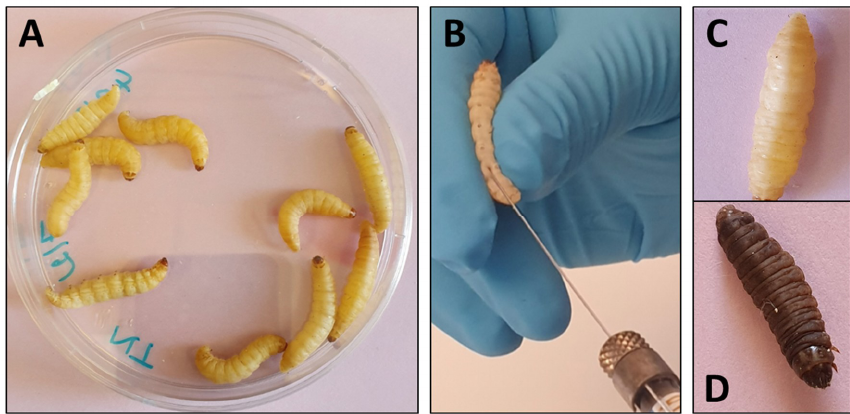
Figure 2. Use of Galleria mellonella larvae for evaluation of antifungal efficacy. ( A ) Larvae are grouped per ten in Petri dishes. ( B ) Inoculation and treatment are performed by injection in the ventral face of the last proleg with a Hamilton syringe. ( C ) Living larva. ( D ) Dead, melanized,